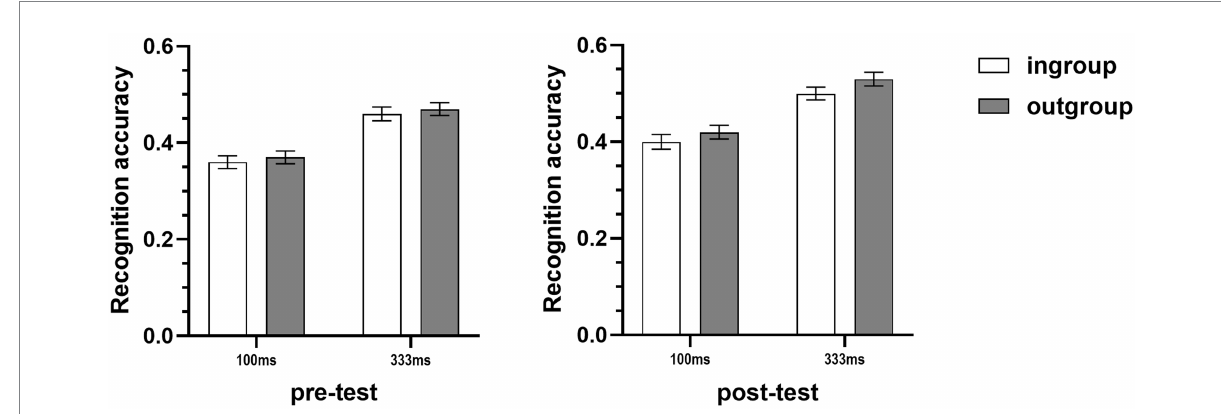
FIGURE 2 Mean recognition accuracies of micro-expressions of ingroup and outgroup members collapsed across two METT training conditions (Study 1A). Error bars represent standard